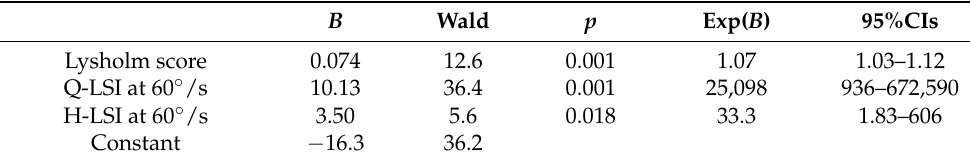
Table 4. Predictive model to return to running from isokinetic LSI